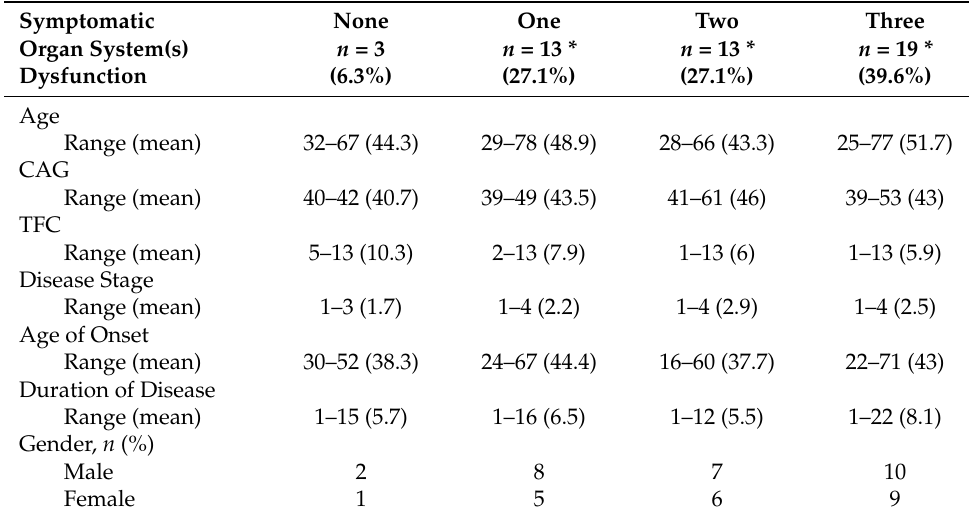
Table 2. Organ systems and concomitant dysfunction.